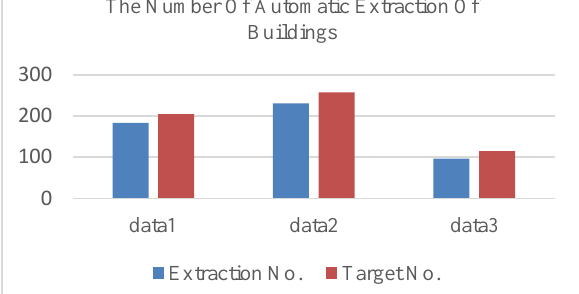
Figure 5. Experimental Worldview3 satellite images